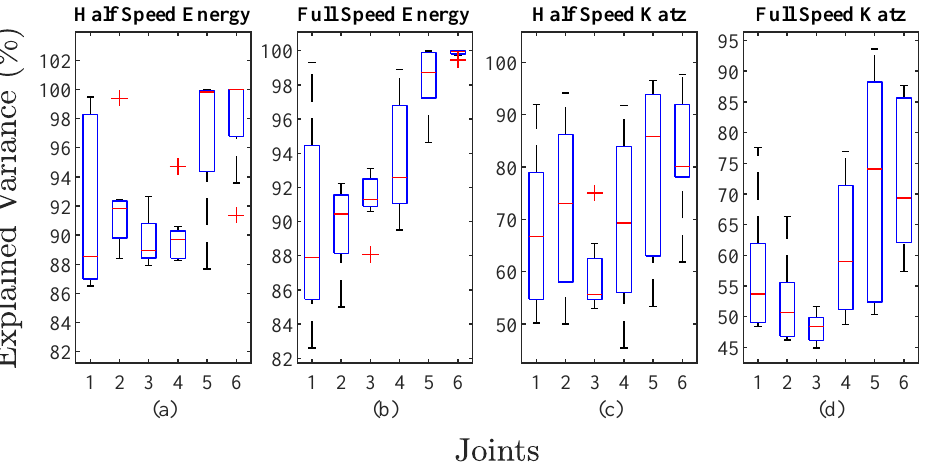
Figure 11. Explained variance accumulated of the two principal components of each joint for half- and full-speed tests: ( a , b ) values corresponding to the energy index for all noise levels (5–20 dB); ( c , d ) values corresponding to the Katz fractal dimension for all noise levels (5–20 dB). The behavior of the variance dispersion is similar in both cases for the energy index; also, it is observed that joint 3 presents the least dispersion in both cases, and the representa- tiveness of the information is better for the energy index. For the Katz index, the dispersion is higher, in order to obtain a compact range dispersion of the explained variance value,